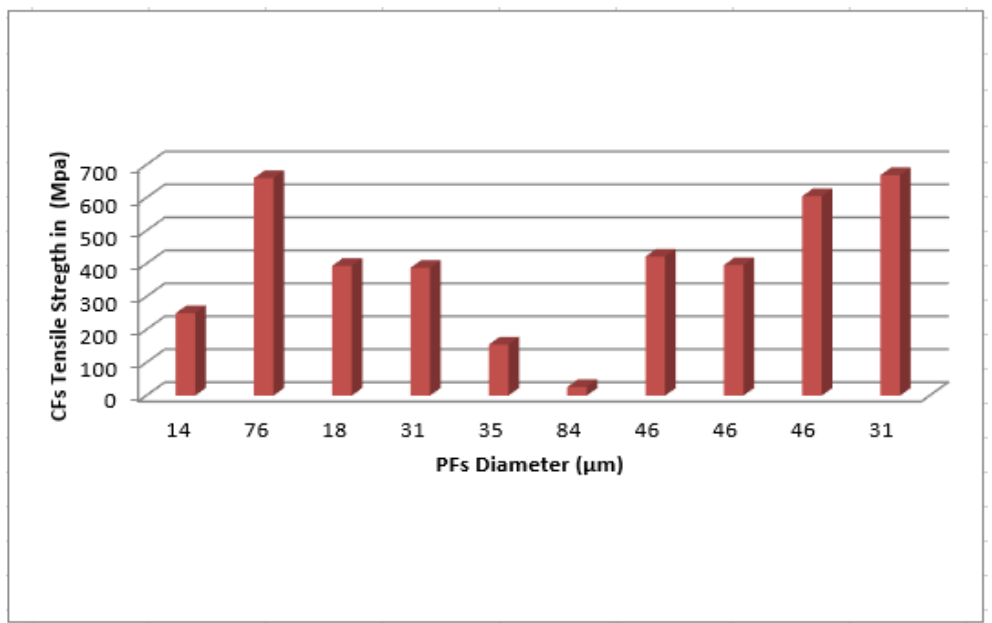
Figure 4. Variation of Strength Property of CFs with PFs Diameter.